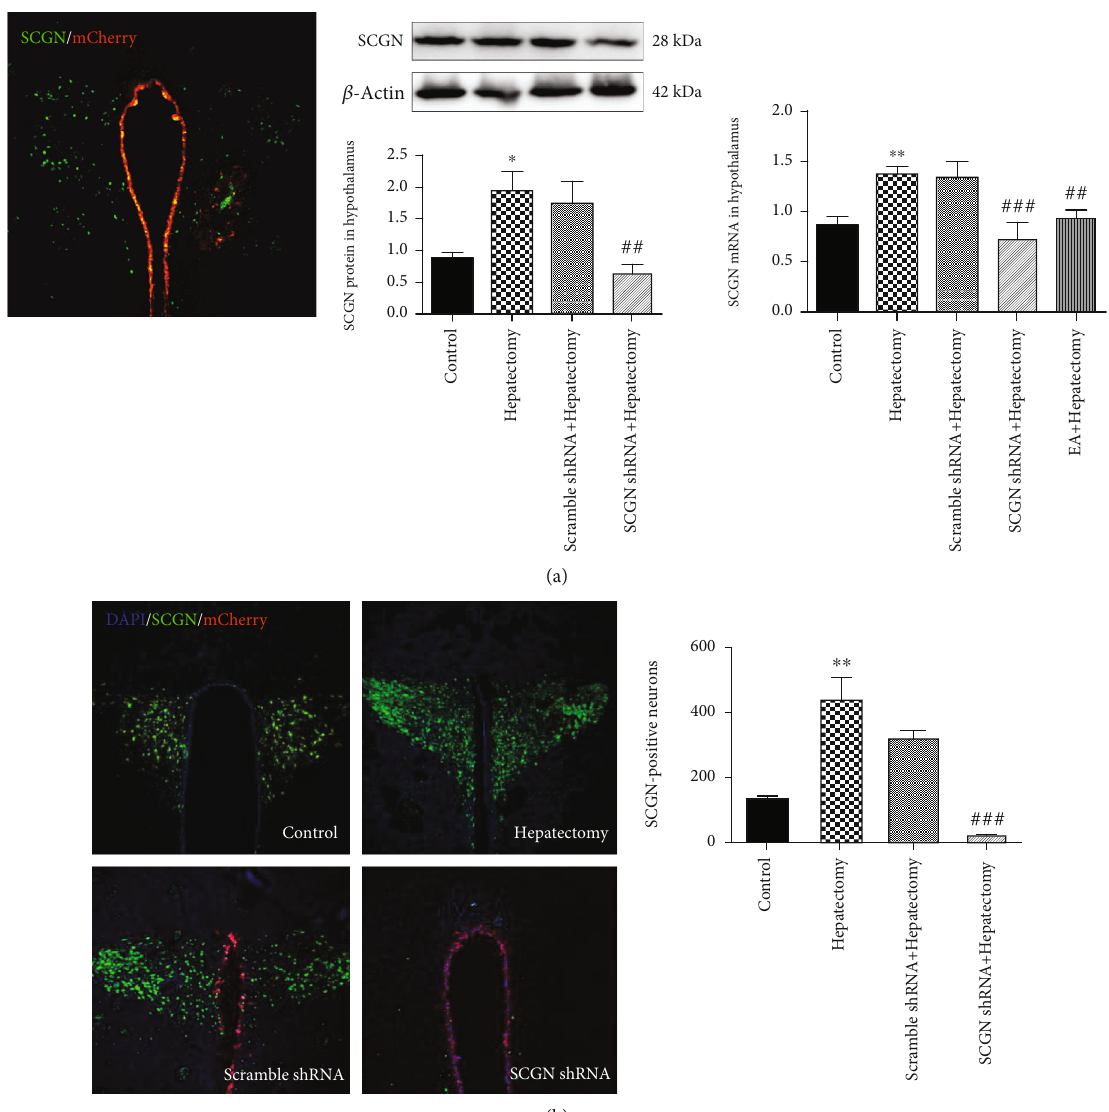
Figure 3: Virus-mediated shRNA knockdown of SCGN in the neurons of PVN in rats and the change of SCGN expression. (a) The CMV viral vector and the locations of the CMV injection sites in rat brain and SCGN levels in the control, hepatectomy, scramble shRNA +hepatectomy, and SCGN shRNA+hepatectomy groups at 24h after hepatectomy. (b) Immuno fl uorescence staining of SCGN, GFP, and DAPI in the PVN and quanti fi cation of SCGN-positive neurons among the control, hepatectomy, scramble shRNA+hepatectomy, SCGN shRNA+hepatectomy, and EA+hepatectomy groups after surgery. Scale bar = 100 μ m . All data are shown as the mean ± SEM ( n = 4 ). ∗ vs. control group ( p < 0 : 05 ): ∗∗ p < 0 : 01 ; # vs. hepatectomy group ( p < 0 : 05 ): ## p < 0 : 01 , ### p < 0 : 001